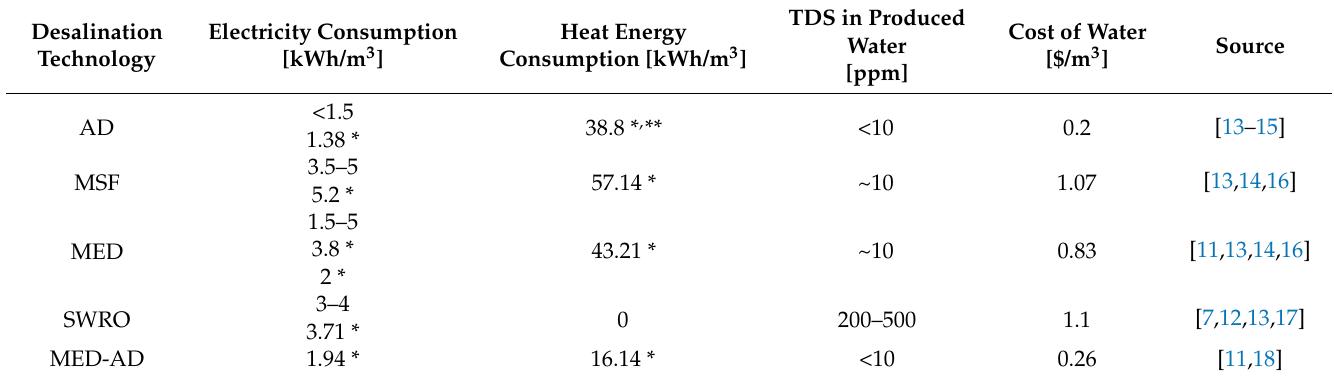
Table 1. Comparison of characteristic parameters of selected desalination